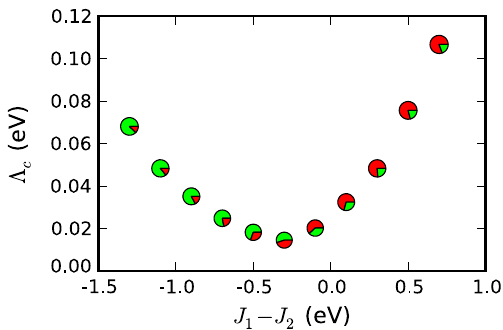
FIG. 11. Variation of the critical scale (cid:3) between pairing channels along a line through parameter space which interpolates between the s described in the caption to Fig. 10, the pairing propensity in each channel is denoted by the angular size of the corresponding sector in the pie chart. A correlation between (cid:3) competition between channels is observed: (cid:3) mum when the two channels in competition have comparable ordering tendency.